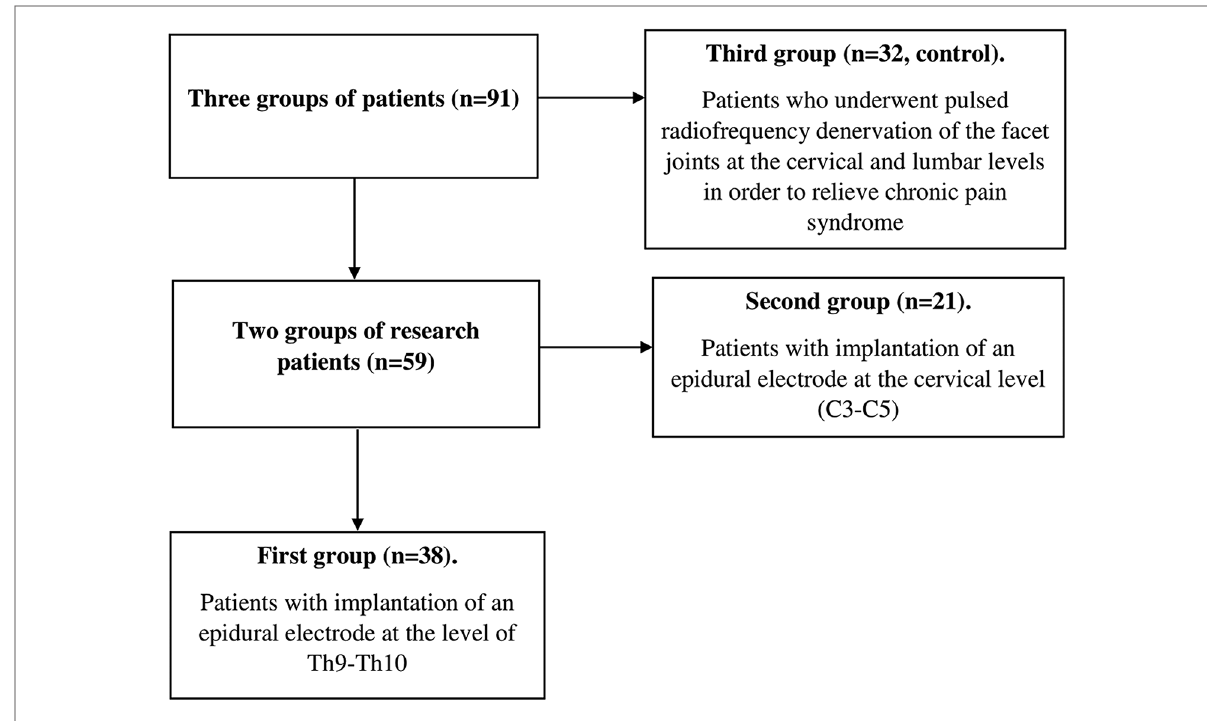
FIGURE 1 Flow-chart of formation of groups for the